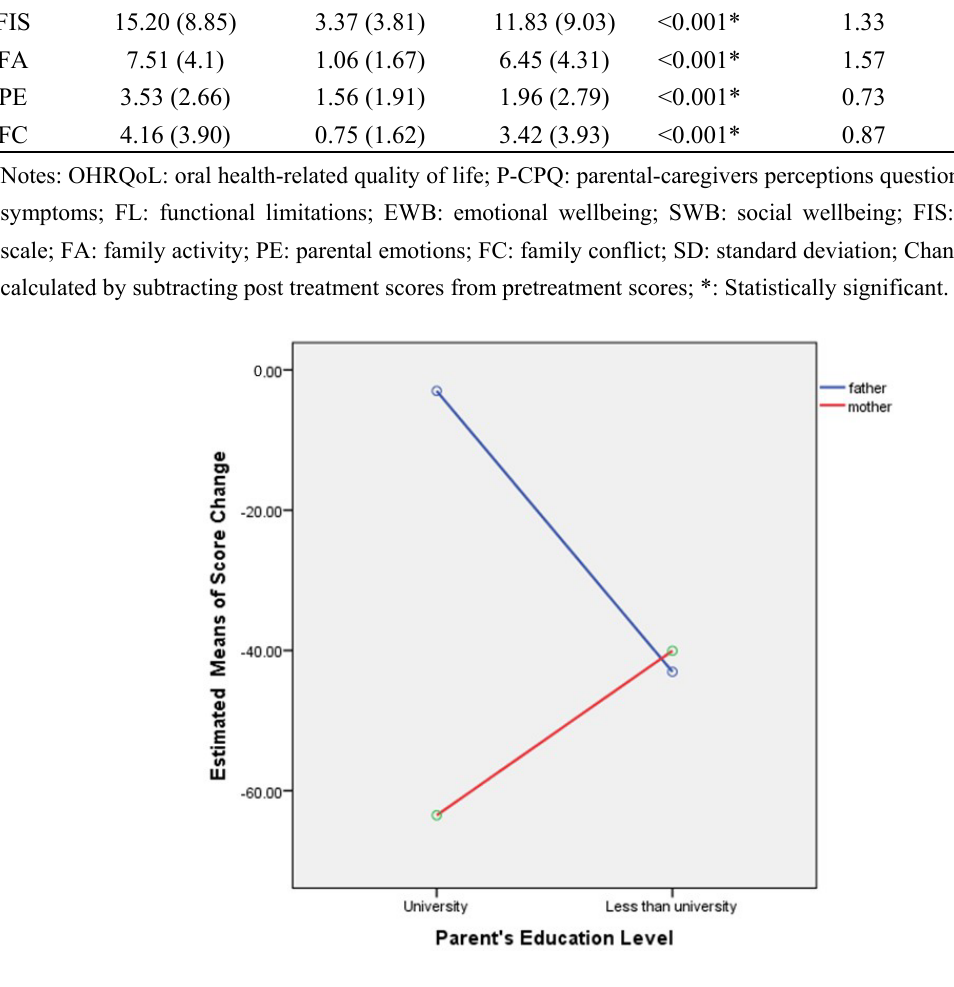
Figure 1. Effects of parent respondent’s sex and education on change score (Parental-Caregivers Perceptions Questionnaire (P-CPQ) plus Family Impact Scale (FIS)). Higher levels of education in mothers yielded higher estimated perceived positive effects as a result of dental